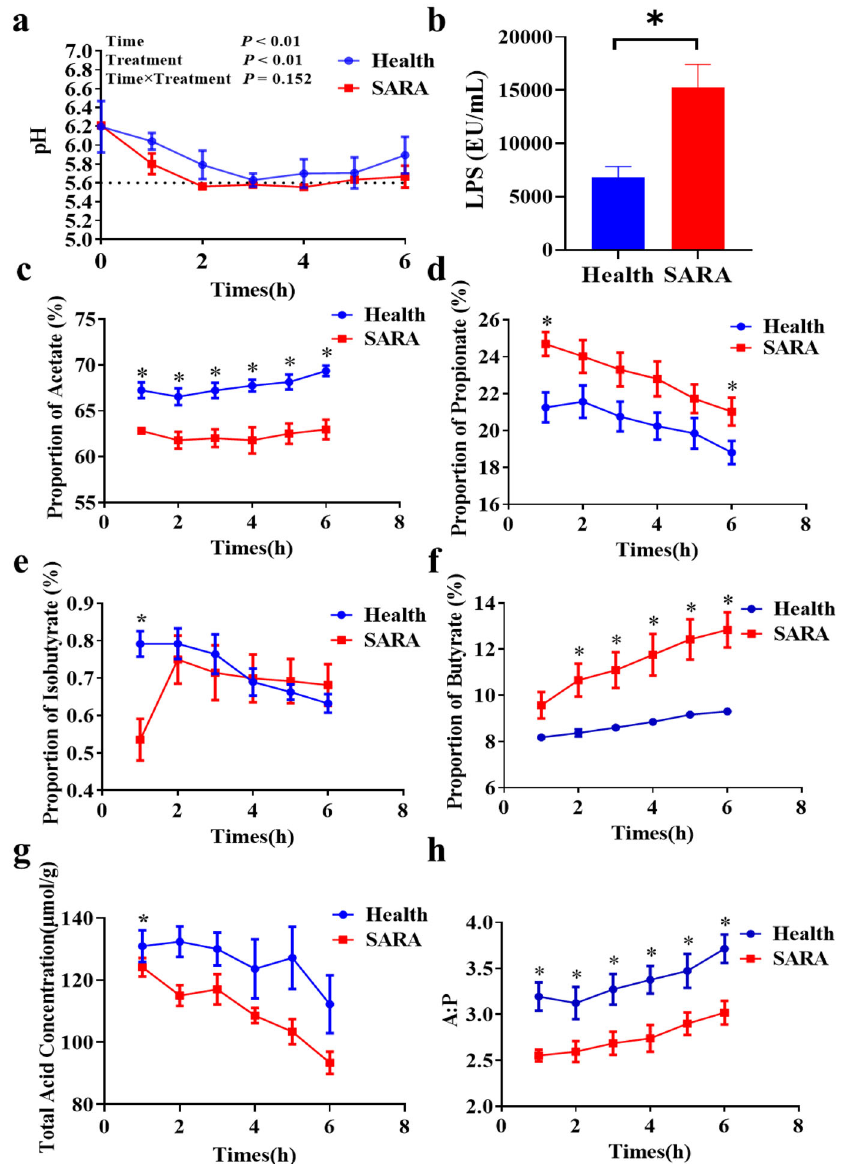
Fig. 1 Rumen fermentation in two groups of dairy goat donors. a Changes in the rumen pH values of two groups of dairy goats 6 ho after feeding. b The difference in the LPS concentration in the rumen of two groups of dairy goats 2 h after feeding. c – h The proportions of ( c ) acetate, ( d ) propionate, ( e ) isobutyrate, ( f ) butyrate, ( g ) the ratio of acetate to propionate, and ( h ) the concentration of total volatile fatty acids of rumen fl uid in two groups of dairy goats 6 h after feeding. The rumen pH values ( a ) were analyzed by the One-way Repeated Measures ANOVA procedure (the repeated measures analysis in the general linear model procedure). The other indices ( b – h ) were analyzed using the Students ’ t -test. Health: the dairy goats in the healthy group, SARA: the dairy goats in the SARA group. *Indicates the difference is at a signi fi cant level with p < 0.05, **indicates the difference is at a signi fi cant level with p < 0.01. Error bars on the graphs represent standard